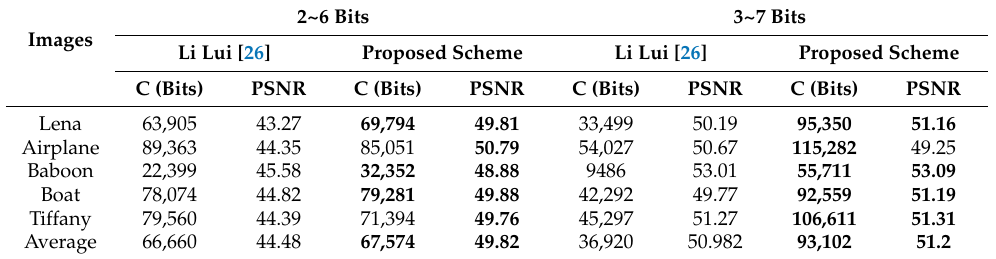
Table 5. Comparison of performance by selecting 5 bit-planes. Bold values highlight the highest results.